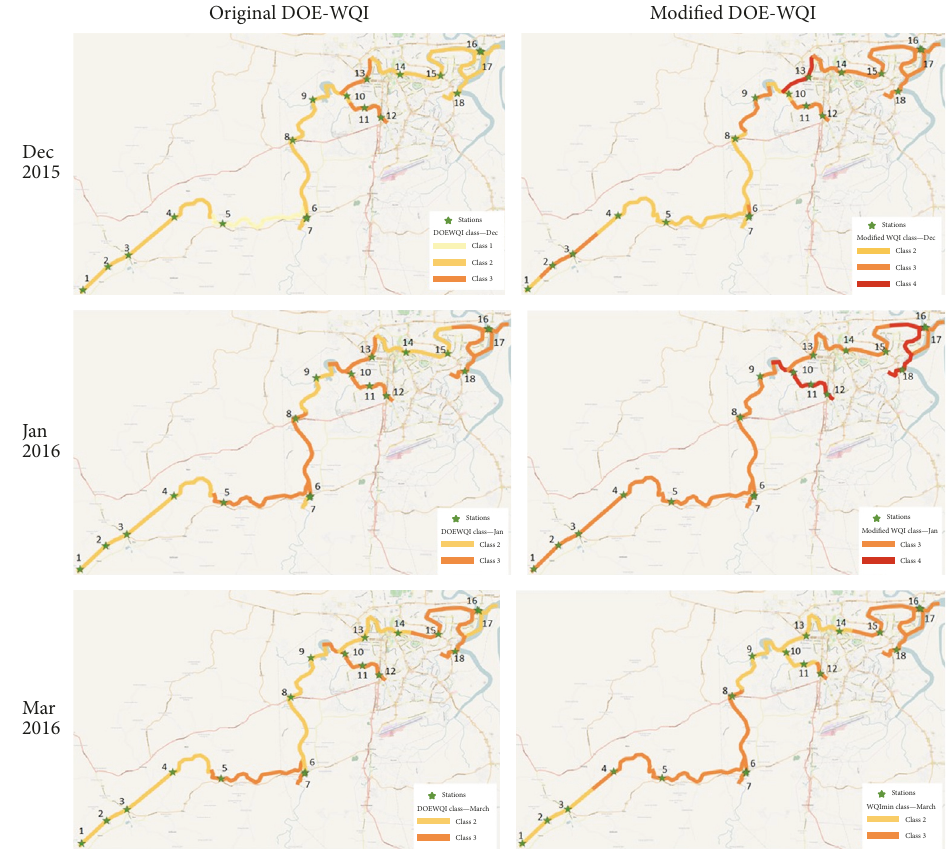
Figure 2: Map representations of the water quality of the Sarawak River and its tributaries.